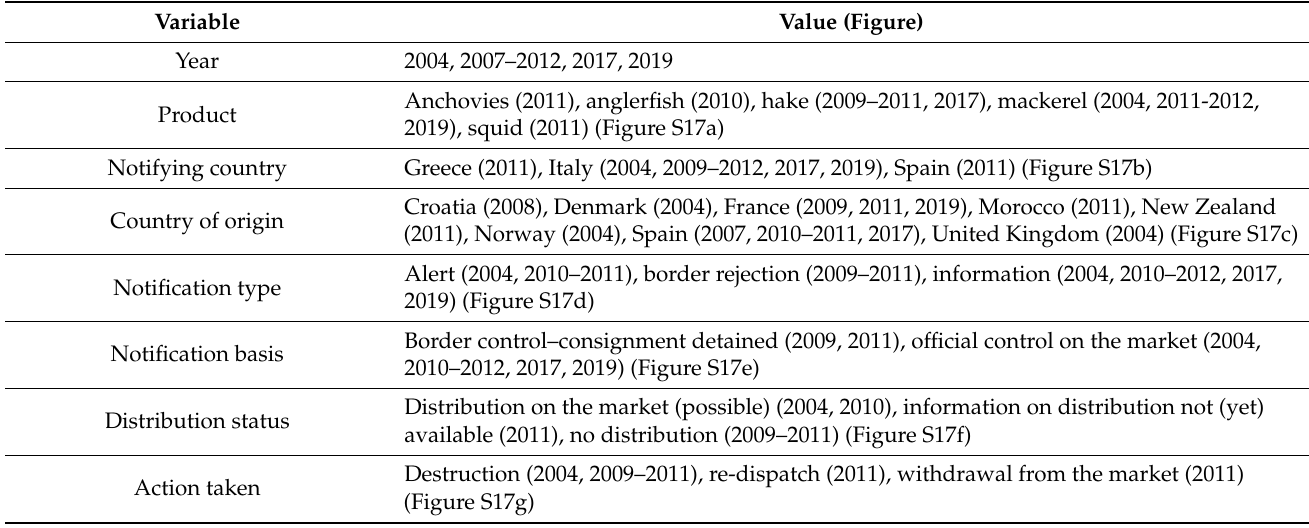
Table 9. Results of two-way joining cluster analysis related to notifications on parasites ( Anisakis ) in